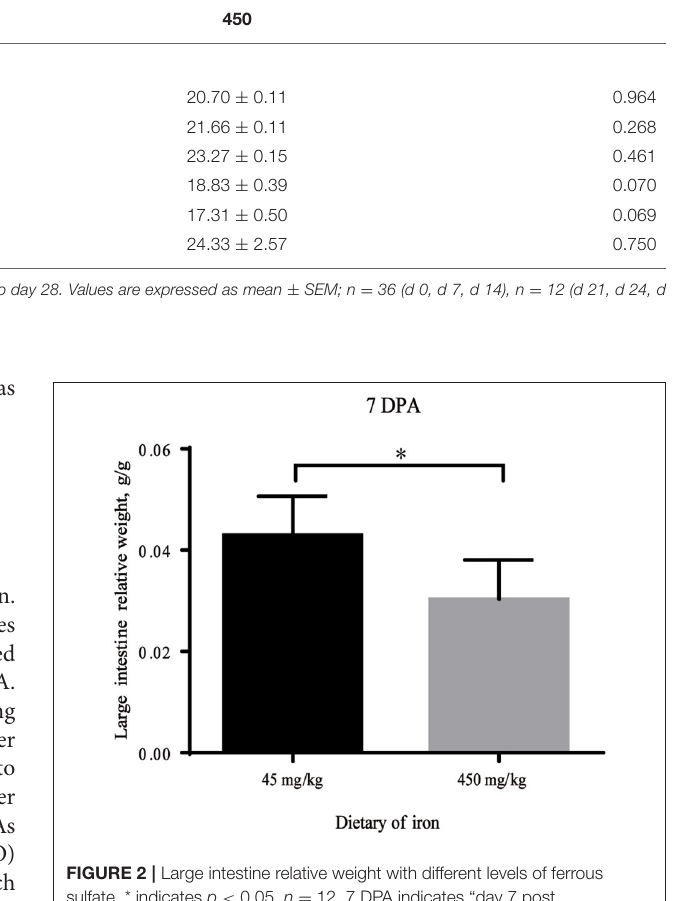
( Figure 3E , P < 0.001) in the high-iron group at 0 DPA, and the jejunum villus width ( Figure 3E , P = 0.033) and jejunum crypt depth ( Figure 3D , P = 0.031) at